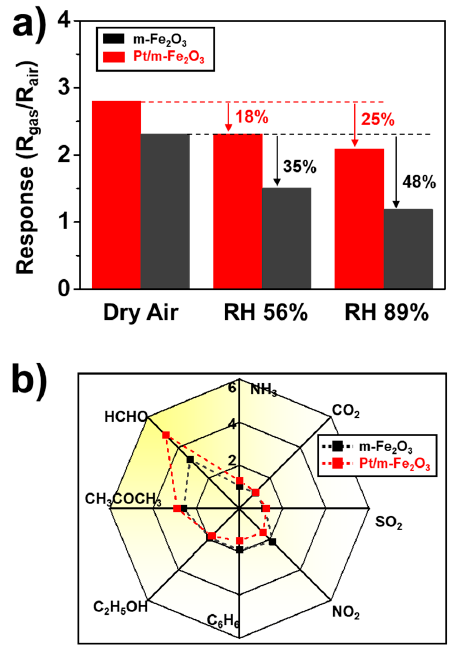
Figure 5. ( a ) Response of m-Fe 2 O 3 and 0.2% Pt/m-Fe 2 O 3 under different relative humidity (Dry air, RH 56% and RH 89%) with respect to the 200 ppb HCHO gas at 300 °C; ( b ) response of m-Fe 2 O 3 and 0.2% Pt/m-Fe 2 O 3 towards 500 ppb of several kinds of gases (concentration of CO 2 was 500 ppm) at 275 °C.